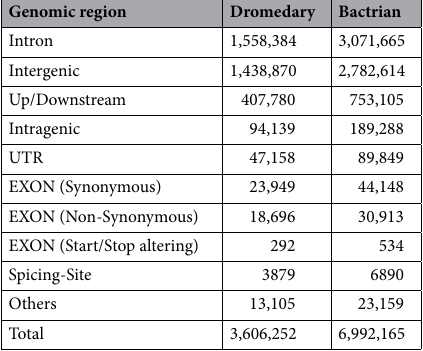
Table 1. Proportion of annotated SNPs in different genomic regions for dromedary and Bactrian camels.